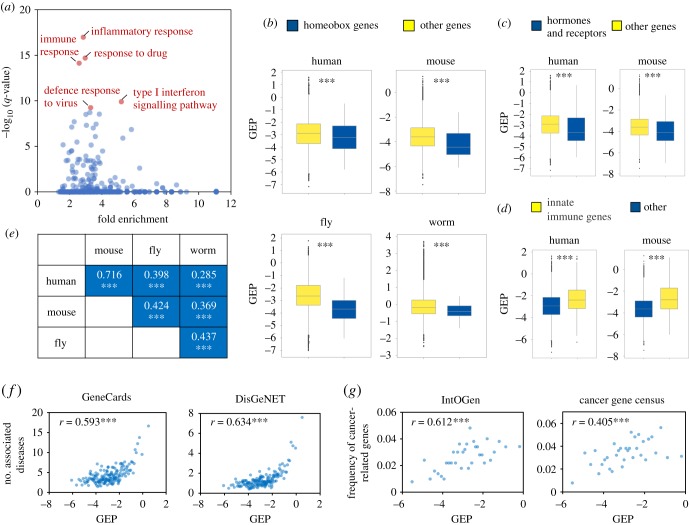
Expression plasticity is associated with gene function and disease susceptibility. (a) Enrichment biological processes for genes with high GEP. Scatter plot shows the fold enrichment and q-values of all biological processes for genes exhibiting high GEP (top 10%, n = 1643). The top five most significantly enriched processes are marked in red. (b–d) Homeobox genes (b) and hormones and receptor genes (c) exhibited significantly lower GEP; innate immune genes exhibited significantly higher GEP (d). *** denotes Mann–Whitney U test, p < 0.001. (e) Ontology term GEP is highly correlated between species. GEP values for each ontology term were calculated by averaging the GEP of all genes belonging to that term. The figure shows the correlation coefficients between ontology term GEP values for all cross-species comparisons. *** denotes p < 0.001. (f) Genes with high GEP are implicated in disease susceptibility. Genes were ranked by GEP and the average number of associated diseases calculated for each bin (100 genes). Gene–disease associations were extracted from GeneCards [19] and DisGeNet [20]. (g) Genes with high GEP are implicated in cancer. Genes were ranked by GEP and the frequency of cancer-related genes was calculated for each bin (500 genes). Cancer-related genes were obtained from IntOGen [21] and the Cancer Gene Consensus [22].